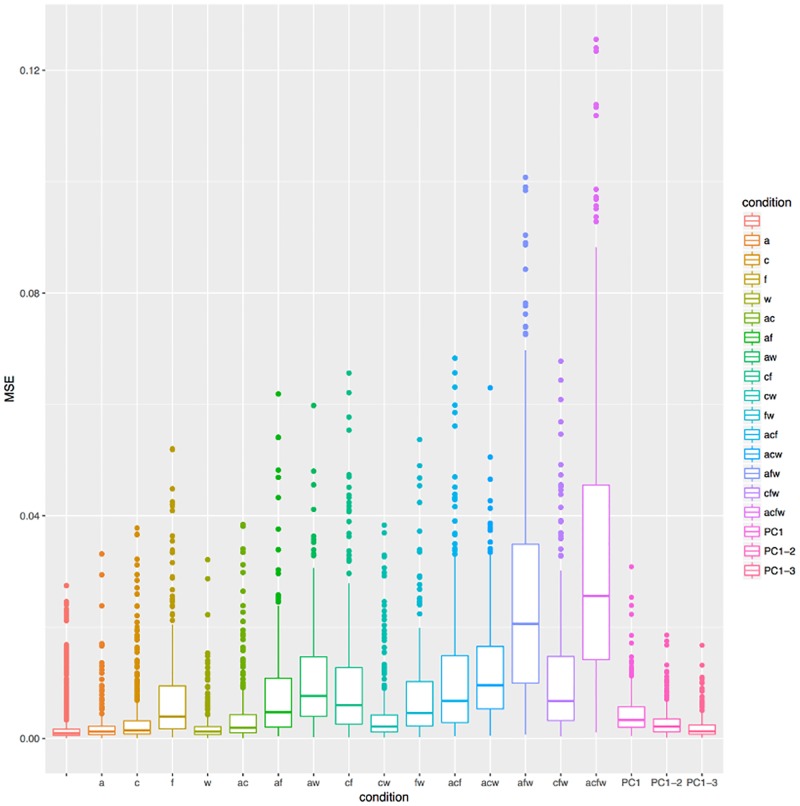
Comparing the goodness of fit of PCA and Bézier-based methods.The first 16 boxplots represent the conditions for the Bézier curve fitting method, while the last three boxplots represent the PCA fitting method using the first PC, the first two PCs, and the three first PCs, respectively (the boxplots are also distinguished using colors). The vertical axis represents is the MSE.